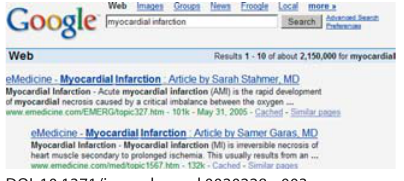
Figure 3. Results of the Search Term “Myocardial Infarction”